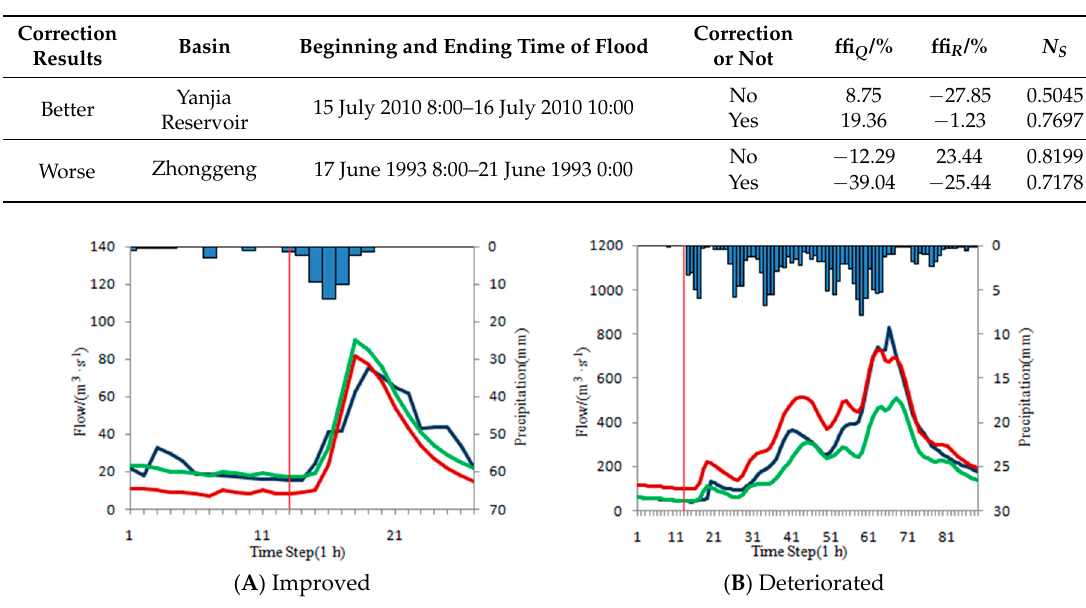
Figure 12. Accuracy improved and deteriorated floods of complex floods.